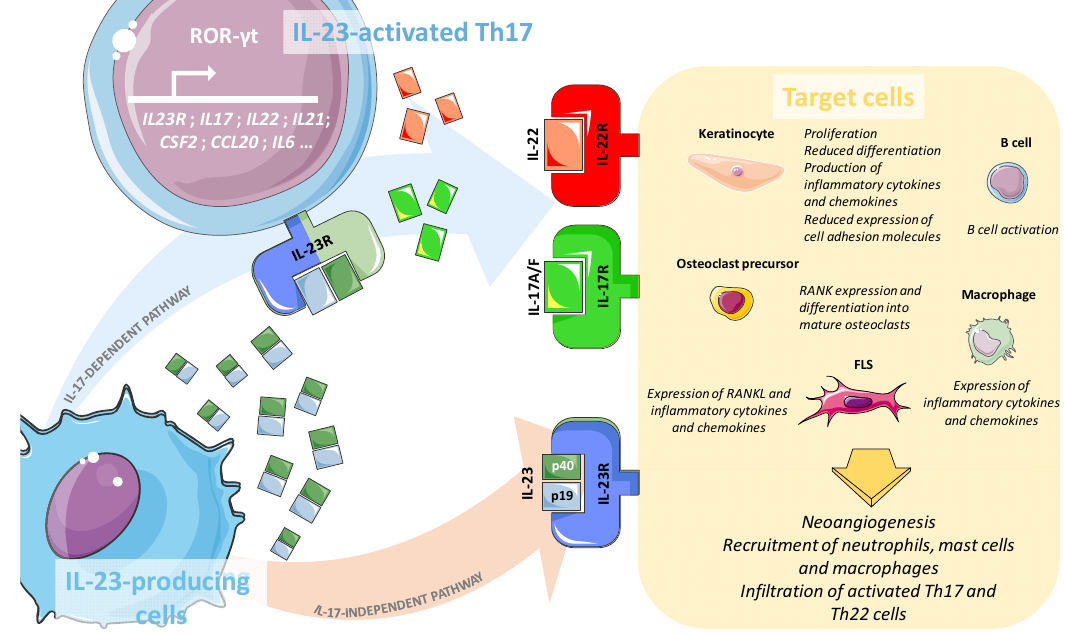
Figure 1. Main players of IL ‐ 23/IL ‐ 17 axis and their roles in the initiation and persistence of inflammation during Psoriasis and Psoriatic Arthritis. IL ‐ 23, mainly produced by dendritic cells, macrophages and keratinocytes acts on numerous target cells via either an IL ‐ 17 ‐ dependent or an IL ‐ 17 ‐ independent mechanism. In the first, IL ‐ 23 stimulates Th17 cells via IL ‐ 23R and induces the release of molecules such as IL ‐ 17 or IL ‐ 22. These, by binding their cognate receptors IL ‐ 17R or IL ‐ 22R, eventually activate the “effector cells” keratinocytes, B cells, osteoclast precursors, macrophages and FLS. Alternatively, the same subset of target cells can be directly challenged by the IL ‐ 23 in an IL ‐ 17 ‐ independent manner. The overall effect of the activation of the IL ‐ 23 pathway consists of the recruitment of inflammatory cells within the inflamed tissue. ROR ‐γ t: Retinoic ‐ acid ‐ receptor ‐ related Orphan Receptor ‐γ t; Th: T helper; FLS: Fibroblasts Like Synoviocytes.